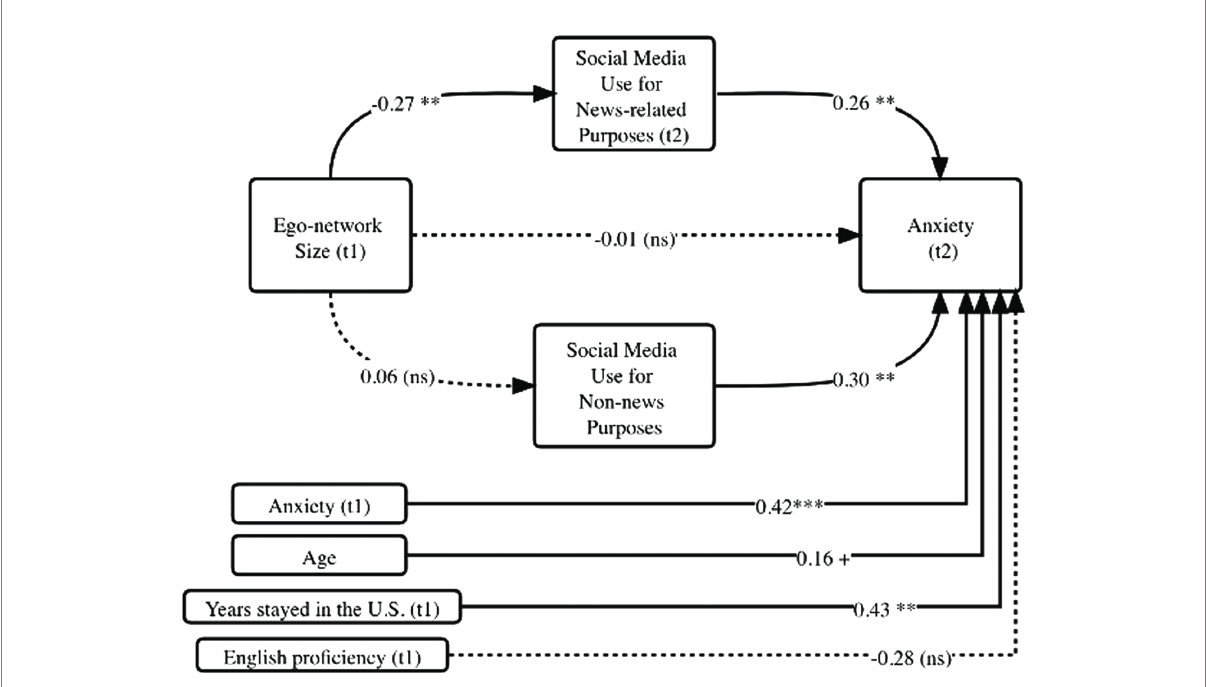
FIGURE 2 Path analysis results with two mediators: social media use for news-related and non-news purposes (Study 1). Dotted lines represent non- significant paths. + p <0.10, ** p < 0.05, *** p < 0.01. Coefficients are